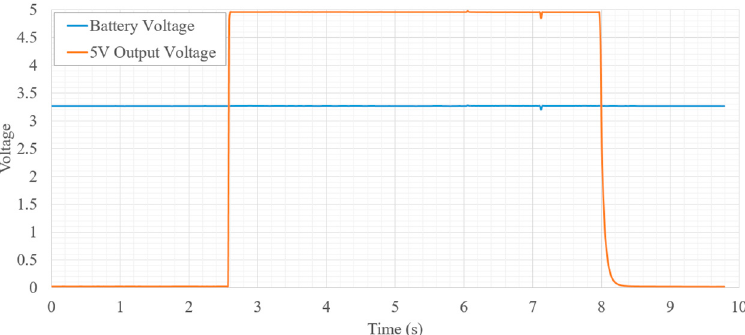
Figure 13. 5 V SMPS power on / off waveforms.